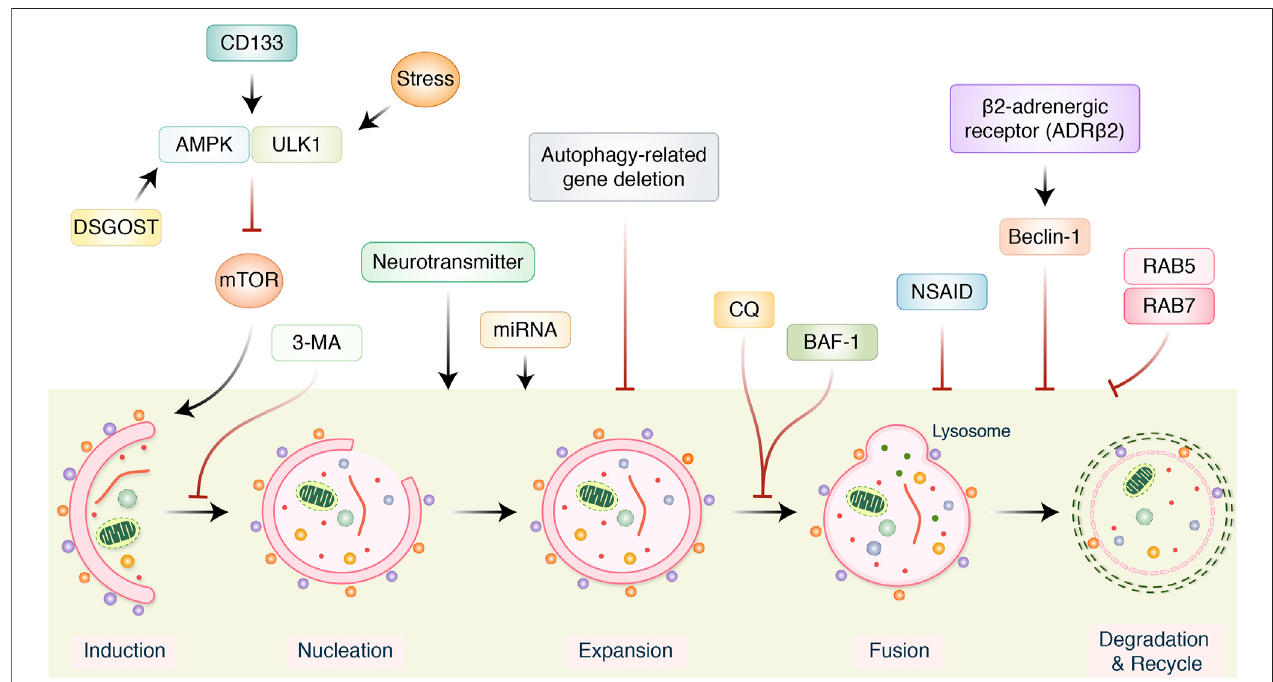
FIGURE 4 | Several signaling pathways modulating autophagy in gastric cancer treatment. AMPK/ULK1 inhibits mTOR pathway, which positively activates autophagy induction. Neurotransmitter and miRNA regulateautophagy induction.However, autophagy-related gene (ATG), 3-metheylalanine (3-MA),chloroquine (CQ), ba fi lomycin A1(BAF-1),and nonsteroidalanti-in fl ammatory drugs(NSAIDs)inhibited and modulated entire autophagy process. β 2 -Adrenergic receptor activates beclin- 1 and inhibits